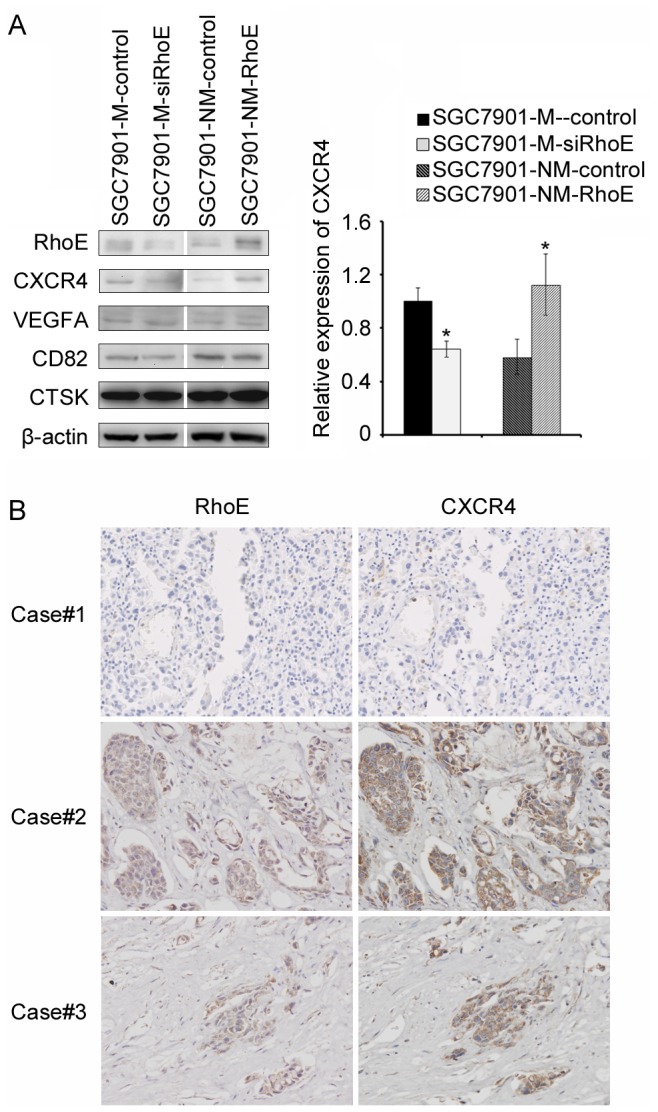
Verification of the expression of downstream genes in different cell-lines by Western blot analysis of RhoE.(A) RhoE, CXCR4, VEGFA, CD82 and CTSK expression of SGC7901-M-control, SGC7901-M- siRhoE, SGC7901-NM-control, and SGC7901-NM-RhoE cell-lines. The expression of β-actin was used as internal control. The relative expression levels of CXCR4 were shown as bar charts. *P <0.05. Values represent the arithmetic mean and standard error of the mean (SEM) as determined from at least three experiments. (B) Immunohistochemical staining of RhoE and CXCR4 in 60 pairs of gastric cancer tissues. Three representative cases showed that CXCR4 expression was well-correlated with that of RhoE.